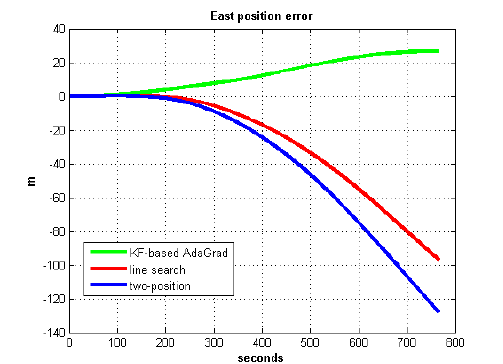
Figure 23. East position error in test 2.